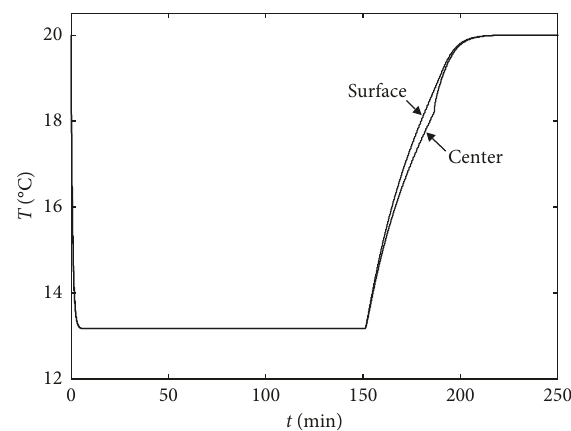
Figure 5: Nonisothermal drying: temporal evolution of temper- ature (centre vs. surface temperature of the sphere particle).